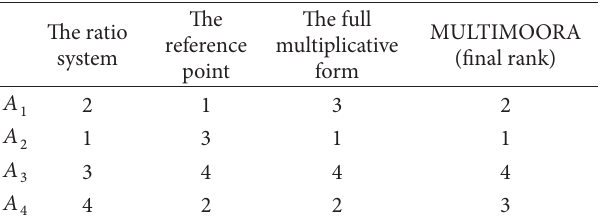
Table 6: Ranking of the alternatives according to